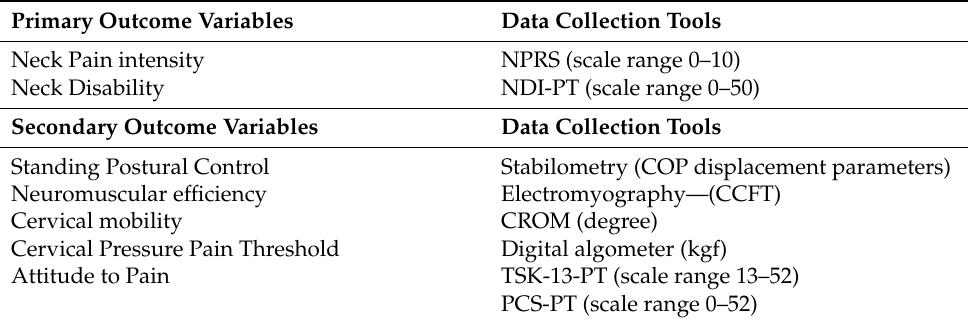
Table 6. Summary of outcome